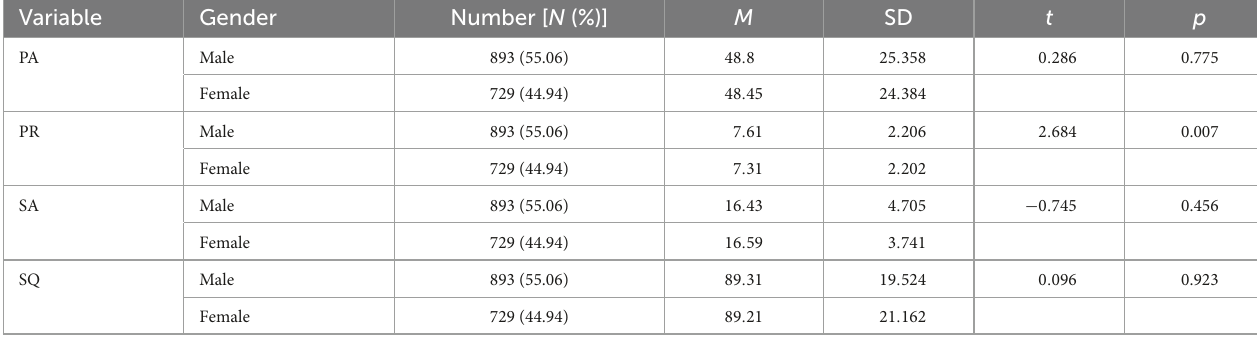
TABLE 2 Differences in gender.